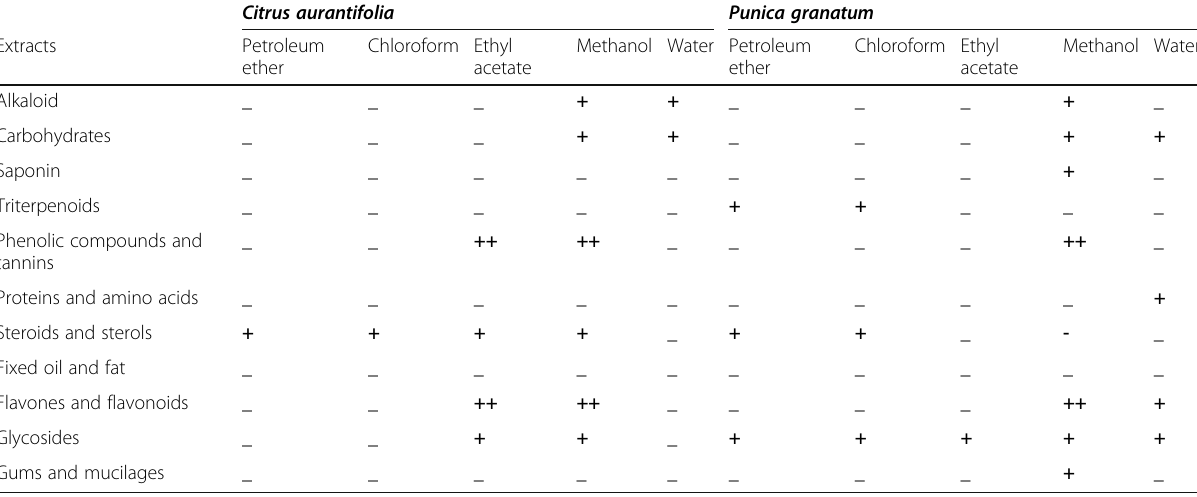
Table 1 Phytochemical screening of extracts of fruit peel of Citrus aurantifolia and Punica granatum Citrus